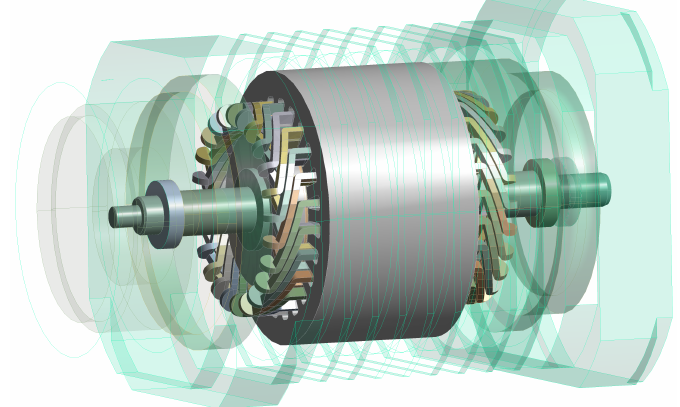
Figure 7. 3D CFD model of the DSOF